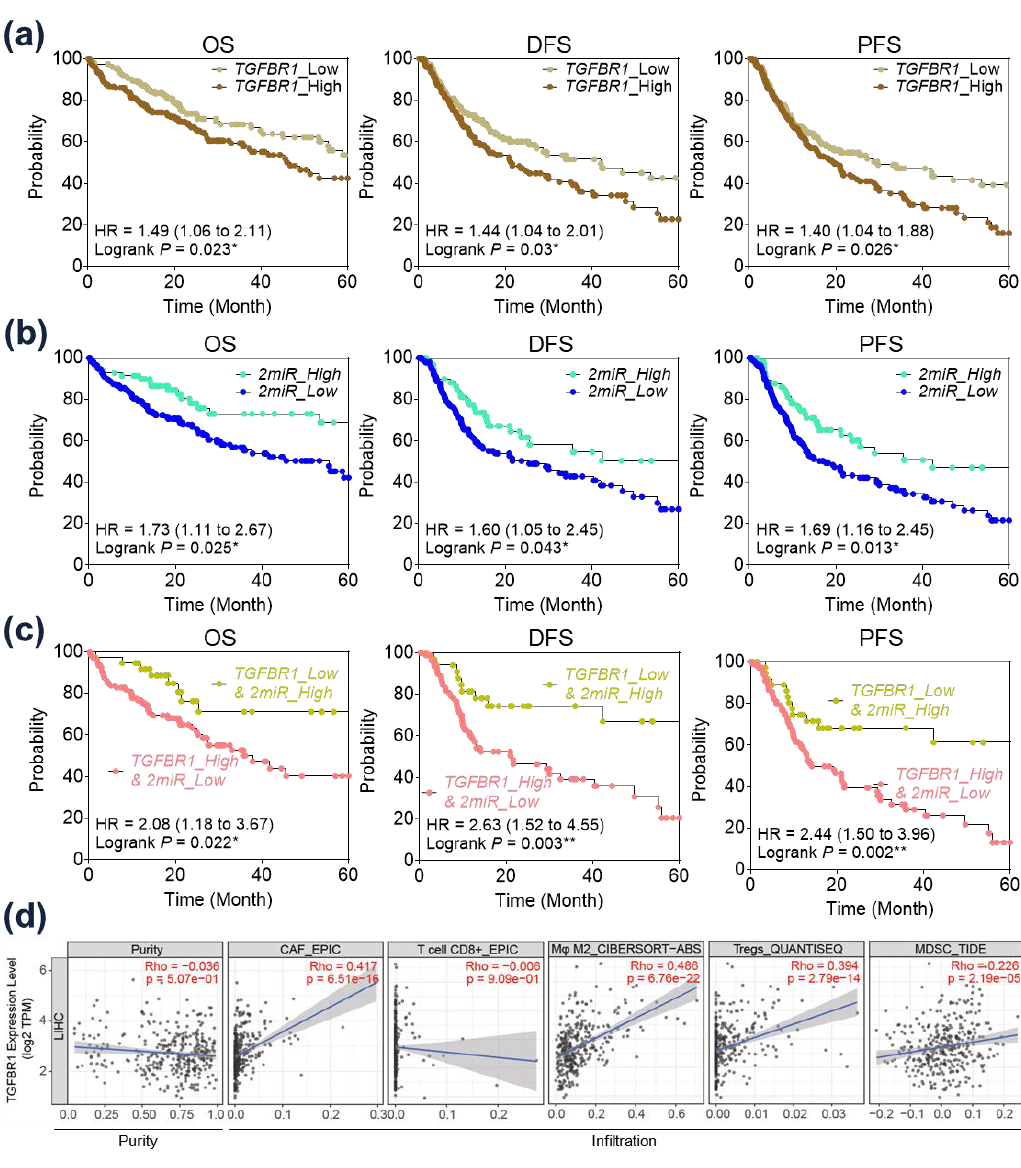
Figure 5. Prognostic and immunological implications of TGFBR1 in hepatocellular carcinoma (HCC) patients. ( a ) Survival analysis of HCC patients according to TGFBR1 expression in The Cancer Genome Atlas Liver Hepatocellular Carcinoma (TCGA_LIHC). ( b ) Survival analysis of HCC patients according to expression of two miRs (miRs: hsa-miR-101-3p and hsa-miR-490-3p ) in TCGA_LIHC. ( c ) Survival analysis of HCC patients according to expression of TGFBR1 and the two miRs in TCGA_LIHC. ( d ) Immune cell infiltration according to TGFBR1 expression as identified with TIMER analysis. ( e ) Correlation analysis of TGFBR1 expression with the Treg, M2, and MDSC cell markers in TCGA_LIHC. * p < 0.05; ** p <